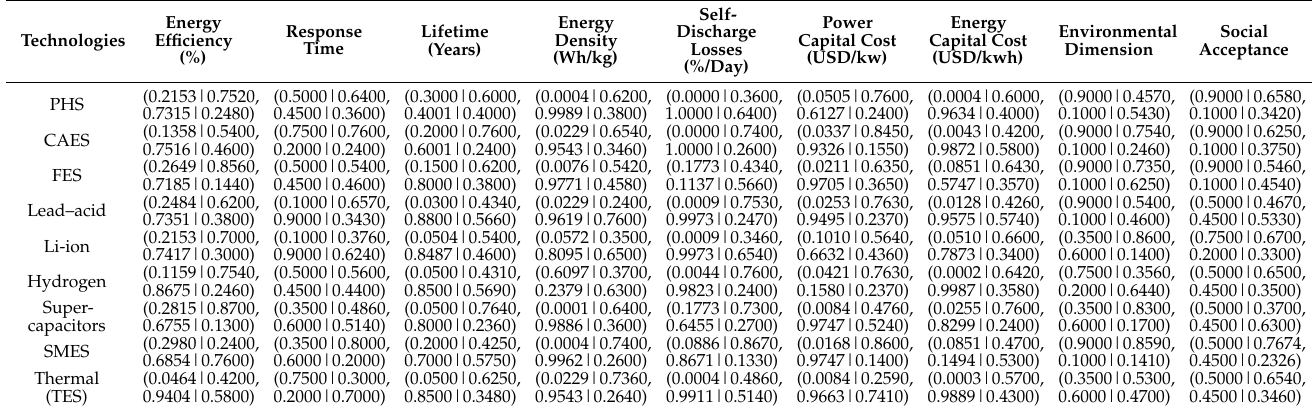
Table A2. Initial decision matrix of Expert 2.